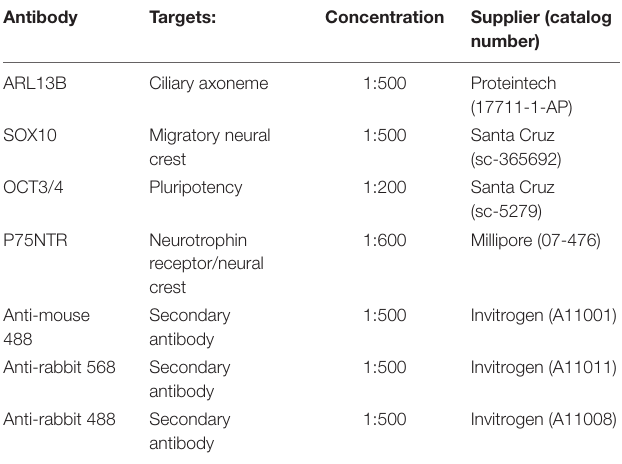
TABLE 2 | Antibodies used in this study.